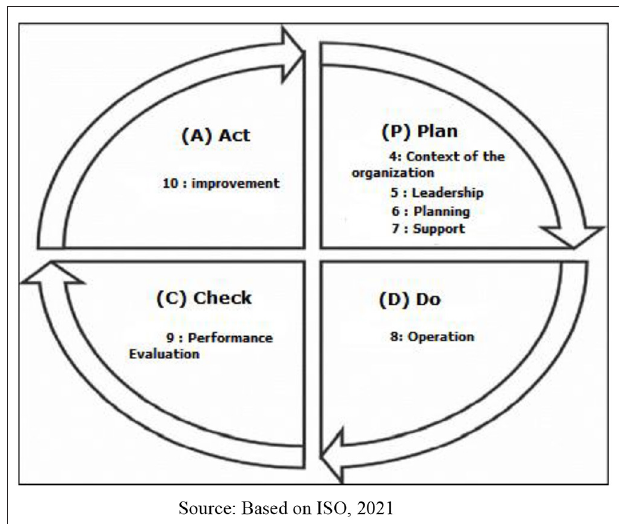
FIGURE 2 | Sections of the Annex SL in each phase of the PDCA cycle. Source: Based on ISO